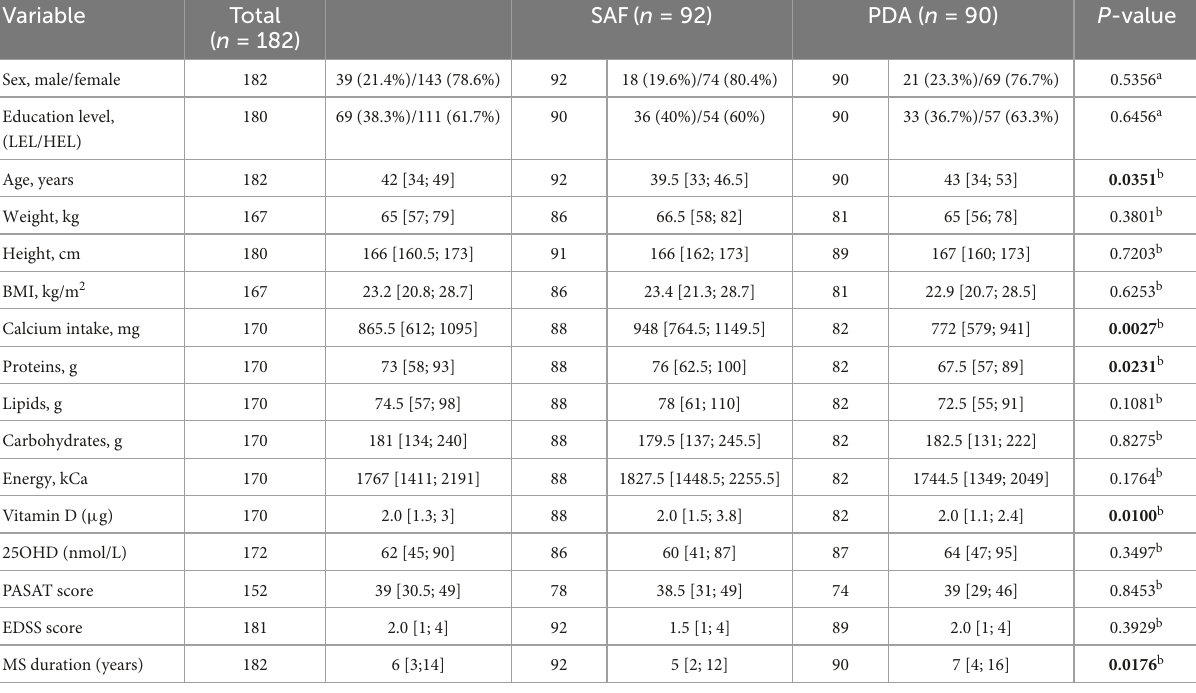
TABLE 1 Baseline characteristics.